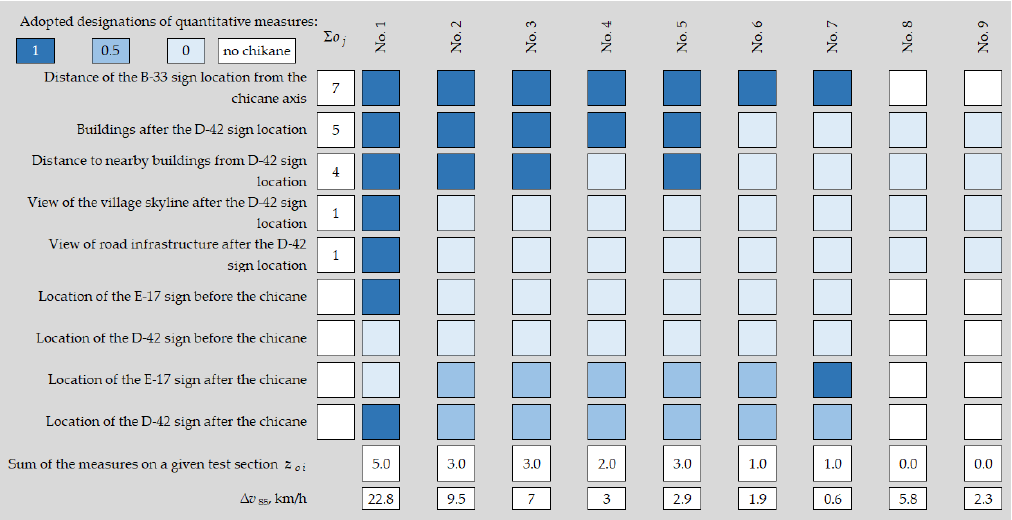
Figure 13. Outcomes of the assessment of the factors associated with the traffic management criterion.